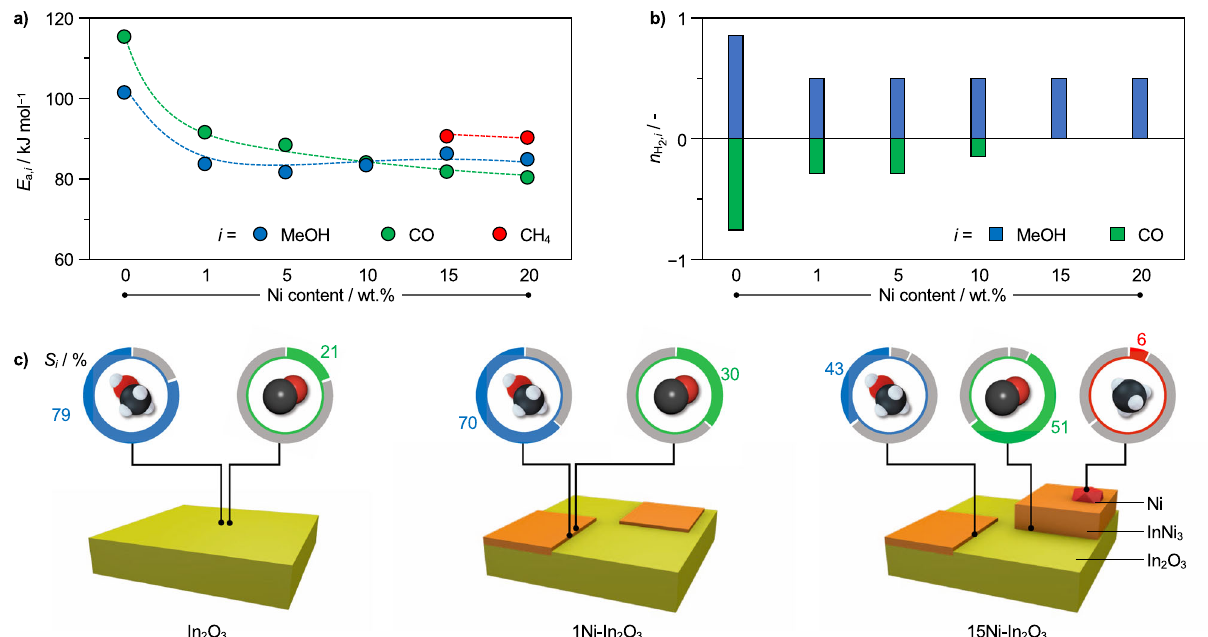
Fig. 6 Nanostructure-driven kinetics and selectivity of nickel-promoted In 2 O 3 catalysts. a Apparent activation energies ( E a ) and b reaction orders respective to H 2 ( n H ) for methanol synthesis and the RWGS reaction over In 2 O 3 catalysts as a function of their nickel content. c Graphical representation of 2 the structures of In 2 O 3 and Ni-In 2 O 3 catalysts with low and high nickel loadings and indications where products shall be predominantly formed on them. The rings surrounding the molecules represent the respective product selectivity. Reaction conditions: T = 553K, P = 5MPa, WHSV = 24,000cm STP 3 h − 1 g cat − 1